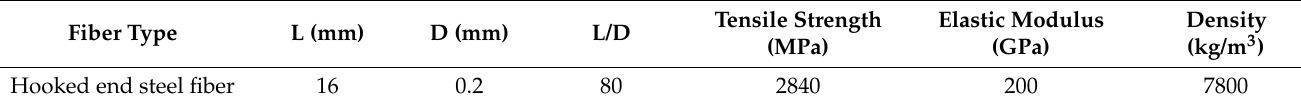
Table 2. Steel fiber parameters.